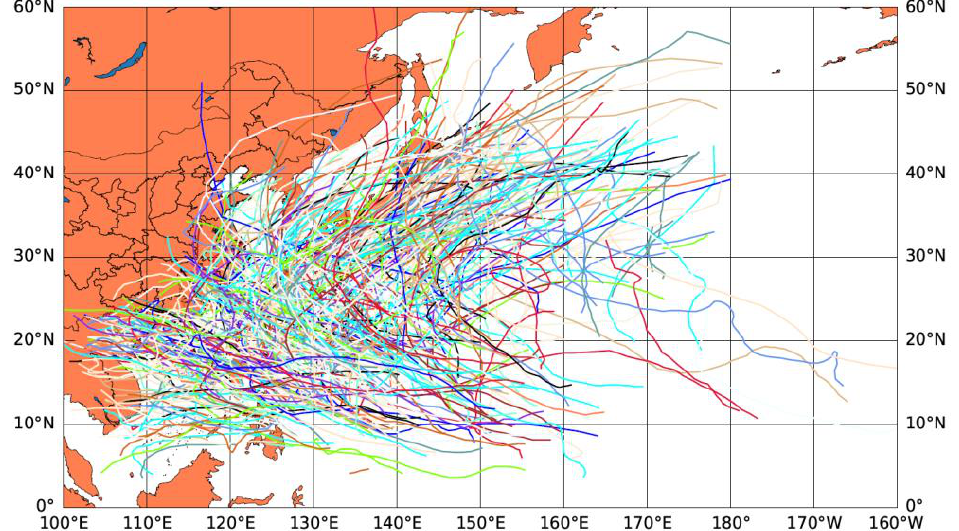
Figure 1. The visualization of the CMA dat aset’s tropical cyclone